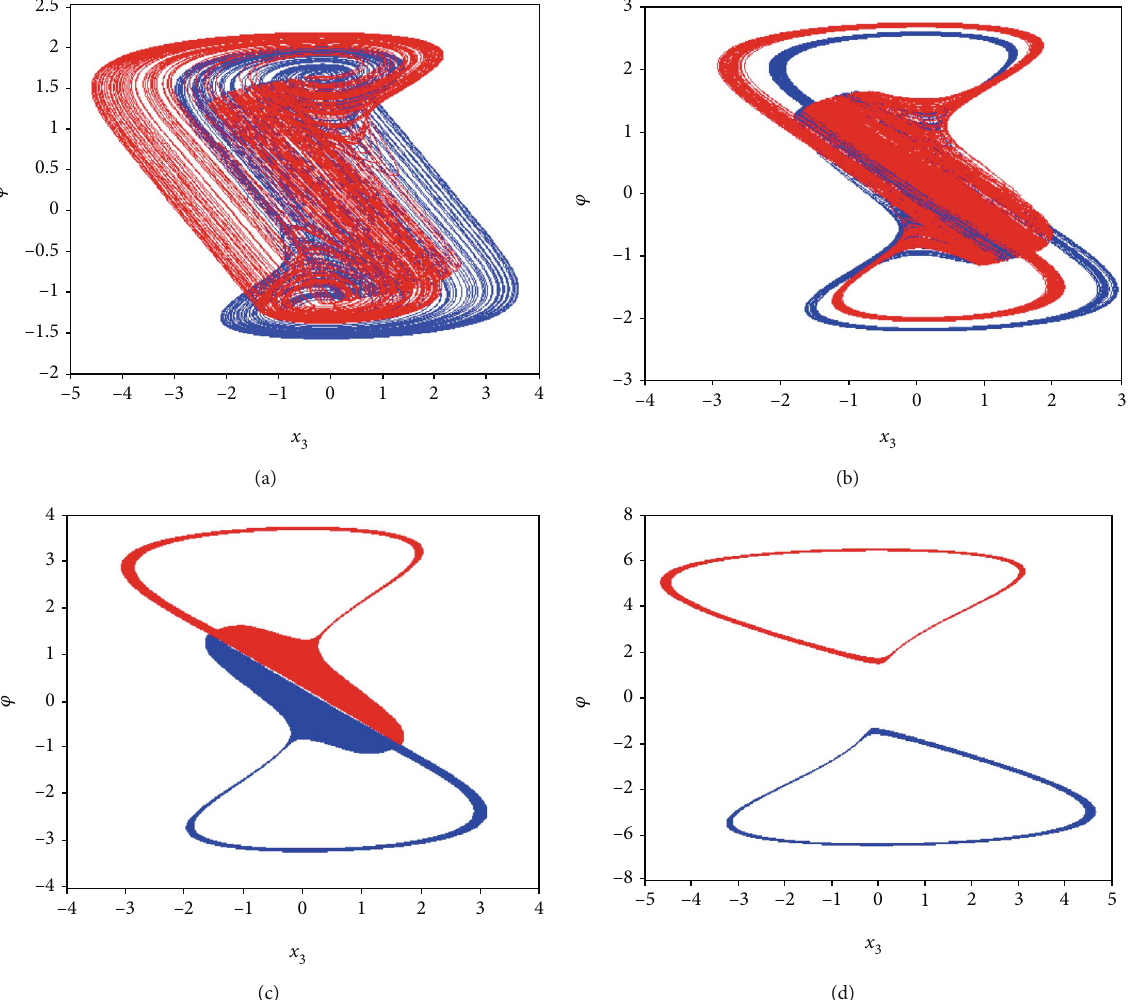
‐ φ plane with di ff erent s ð 0 : 1,0, 0 : 1, 0 : 3 Þ (blue) and ð 0, 0, 0 : 3,0 Þ (red): Figure 5: Coexisting attractors on the x 3 13 under the initial conditions of (a) coexisting chaotic attractors with s 13 = 7 , (b) coexisting chaotic attractors with s 13 = 20 , (c) coexisting periodic attractors with s 13 = 50 , and (d) coexisting periodic attractors with s 13 = 200